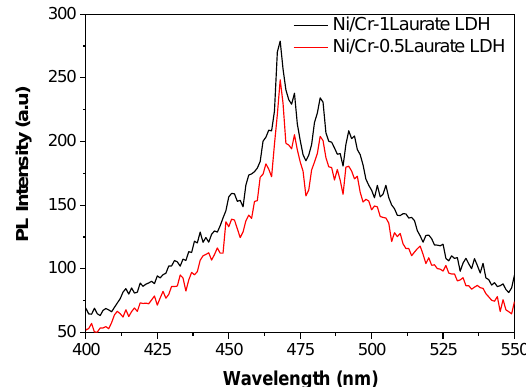
Figure 3. Diffuse reflectance UV−vis spectra of Ni/Cr(2/1)−xLA LDH(x = 1.0, 0.5) and Mg/Cr(2/1)−1.0LA LDH.